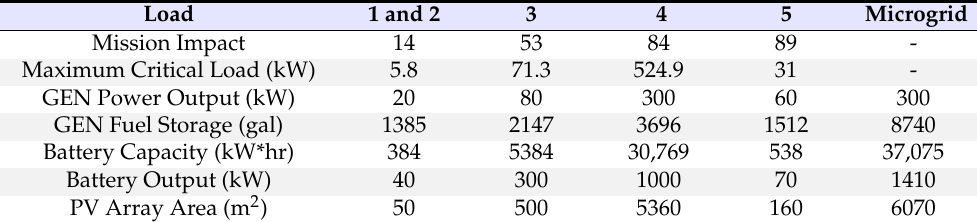
Table 3. Nanogrid DER Sizing Data. Sizing of generator power output is derived from specification sheets from generator datasheets [59–62]. Fuel storage for each generator is calculated for a 7 day period based on fuel consumption rate. PV array size is determined by simulating PV power output from solar irradiance data based on each nanogrid relying solely on PV generation and ESS storage.